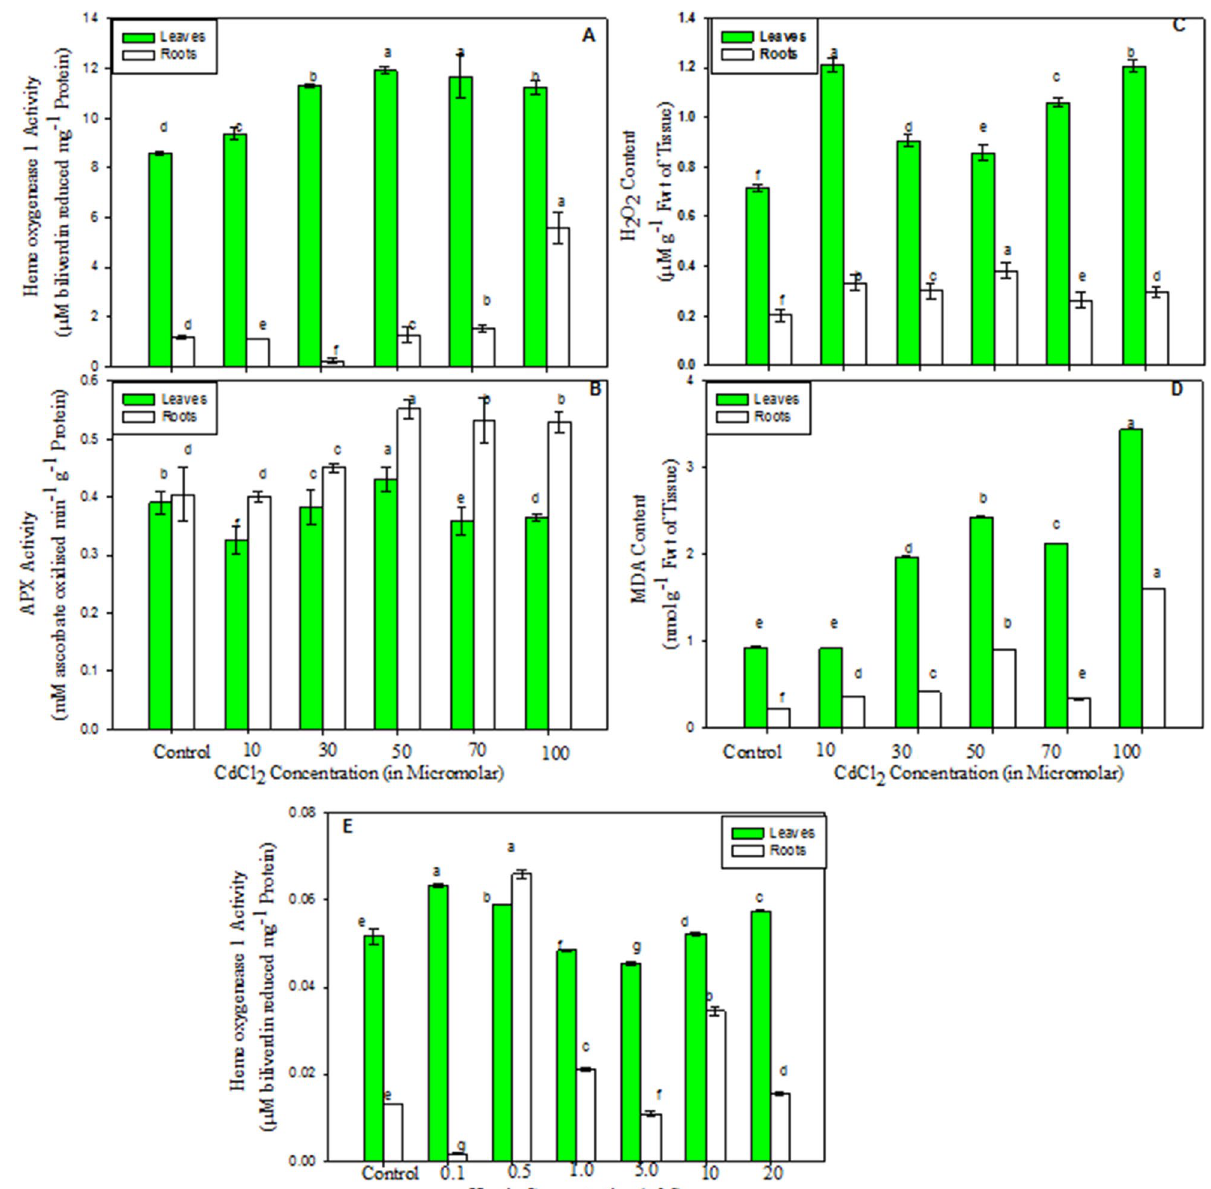
Figure 5. Dose dependent effect of CdCl 2 (10 μM to 100 μM) (from A to D ) and hemin (0.1 to 20 mM) ( E ) on antioxidants activity: HO-1 ( A & E ) and APX ( B ); Oxidative damage: H 2 O 2 ( C ) and MDA content ( D ) in Vigna radiata . Seedlings were treated independently for a period of 96 h to select the optimum concentration of CdCl 2 and hemin for further analysis. Values are mean ± SE (n = 3) and are statistically significant according to DMRT test (p < 0.05). Data points marked with the different letters show significant differences (p < 0.05) within